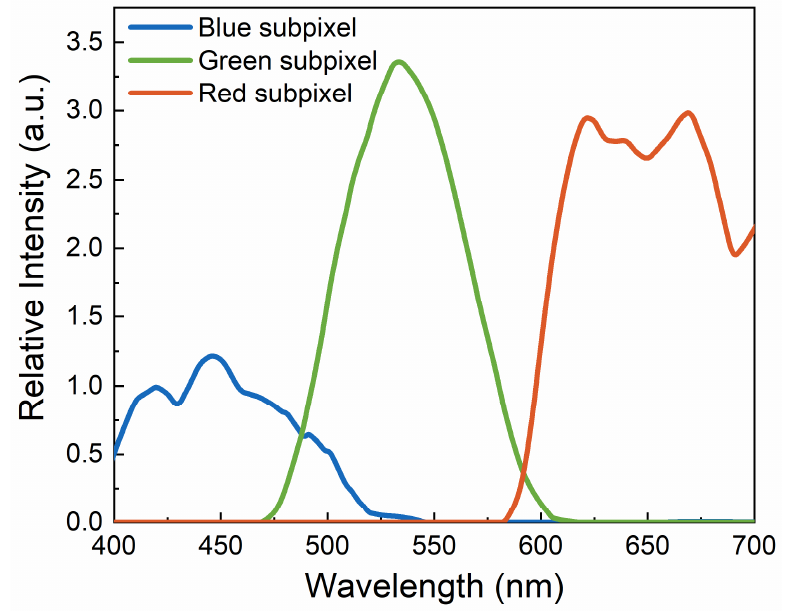
6 Table 2. Relative light intensity and luminous ambient reflection of structure I, II, and III. Structure (α, β)